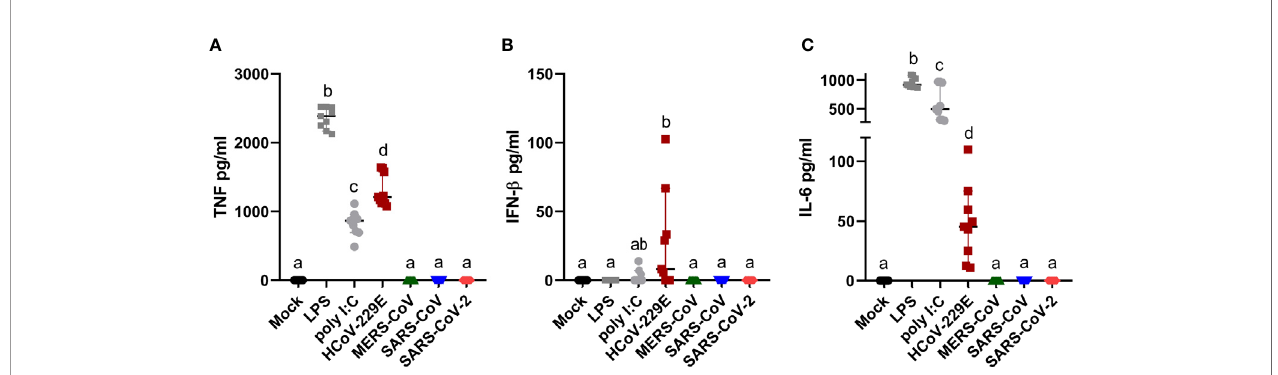
FIGURE 3 | Human MDM immune response after coronavirus infection. Human MDM were inoculated with different coronaviruses (hCoV-229E, MERS-CoV, SARS- CoV-1 and SARS-CoV-2) as described before. Mock-infected cells or cells treated with LPS or poly I:C served as controls. After 24 hpi TNF (A) IFN- b (B) and IL-6 (C) were determined in the cell culture supernatants. The data from three independent experiments run in triplicates are shown. Different superscript letters indicate a signi fi cant difference (p < 0.05) between the conditions.